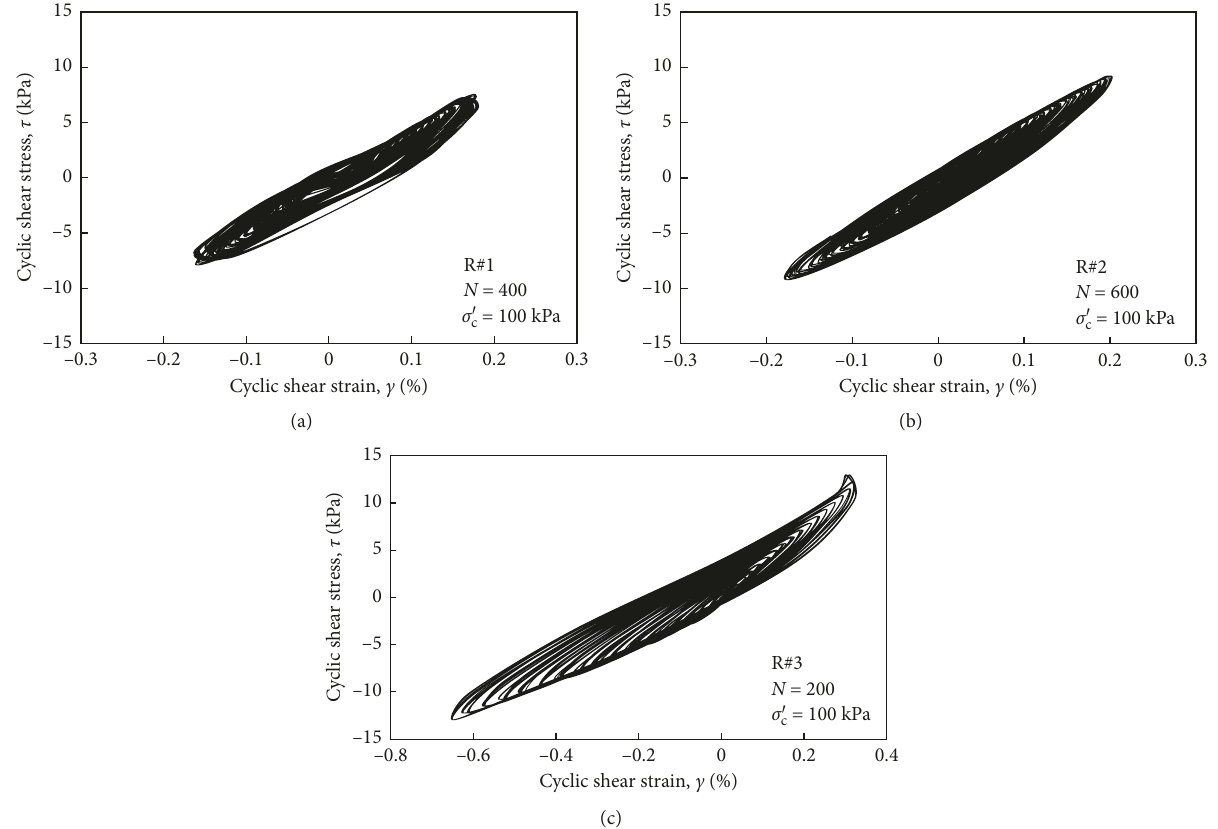
Figure 4: Typical cyclic stress-stain behavior of rubber materials used in the study.